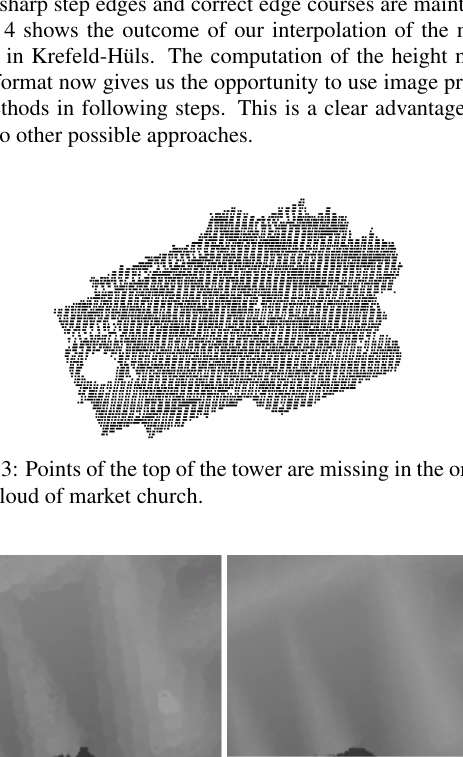
Figure 4: Left: A height map based on the distance weighted mean values from the k nearest neighbors shows stripe-like ar- tifacts that result from irregular distribution of LiDAR points. Right: In a height map generated by our interpolation method, artifacts are eliminated but step edges are maintained.